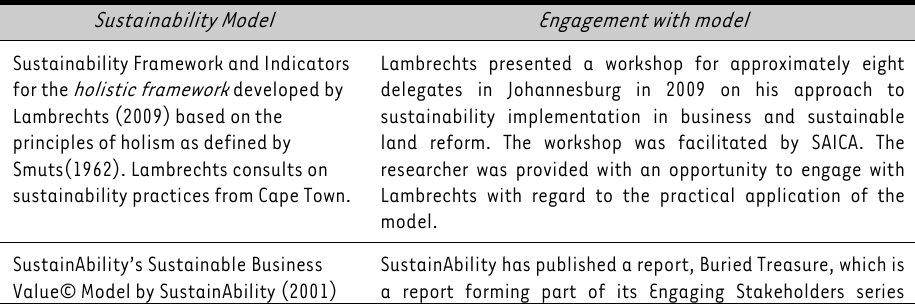
Sustainability models as units of analysis Sustainability Model Engagement with model Sustainability Framework and